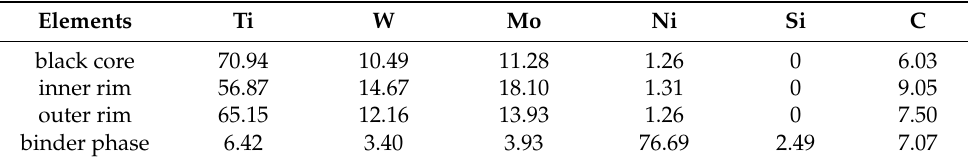
Figure 9. BSE-SEM images of cermets with different ratios of SiC p to SiC w : ( a ) 0.0SiC p 2.0SiC w ; ( b ) 0.5SiC p 1.5SiC w ; ( c ) 1.0SiC p 1.0SiC w ; ( d ) 1.5SiC p 0.5SiC w . Table 3. Composition of cermet I with 1.5 wt.% SiC p and 0.5 wt.% SiC w (wt.%).